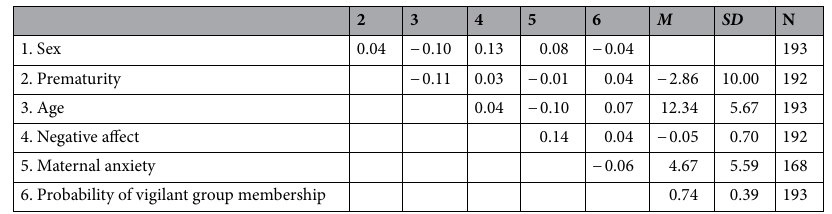
Table 5. Descriptive statistics and correlations LPA model. No relations were significant at the p < 0.05